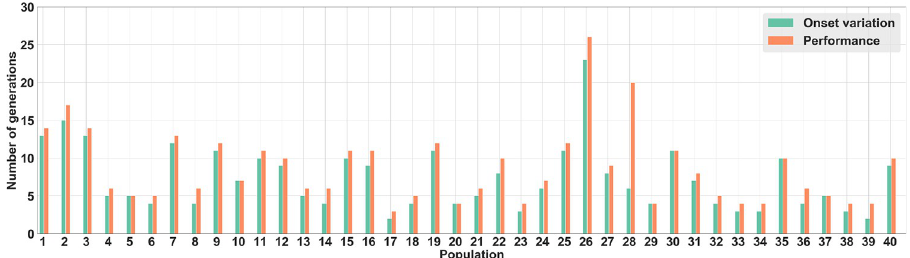
Fig 6. Number of generations before using signal onset-delay and surpassing performance threshold. For each of the 40 populations, number of generations required before senders changed signal onset-delay depending on the site at which food was located (in green). Number of generations required for the mean population performance to surpass the maximum performance (i.e., 0.2) in the no-communication populations (in